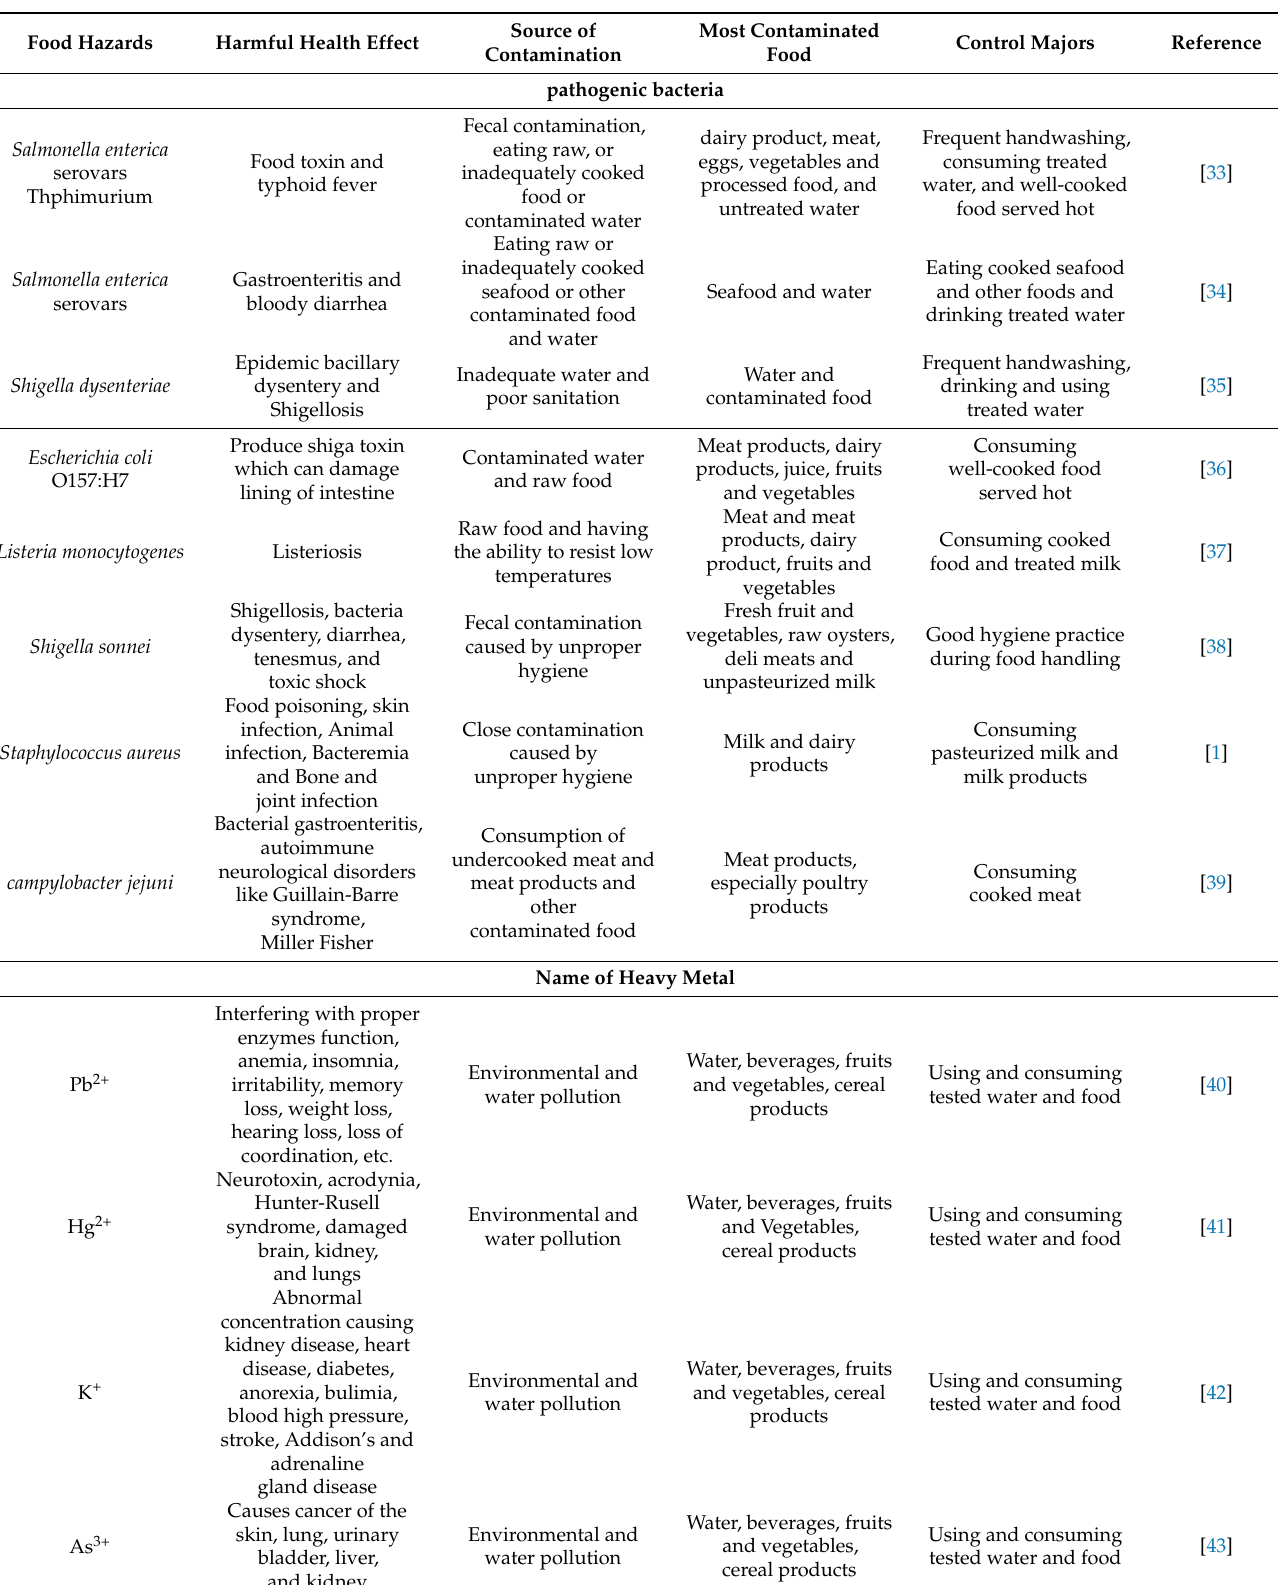
Table 1. Occurrence and health effects of food hazards and food